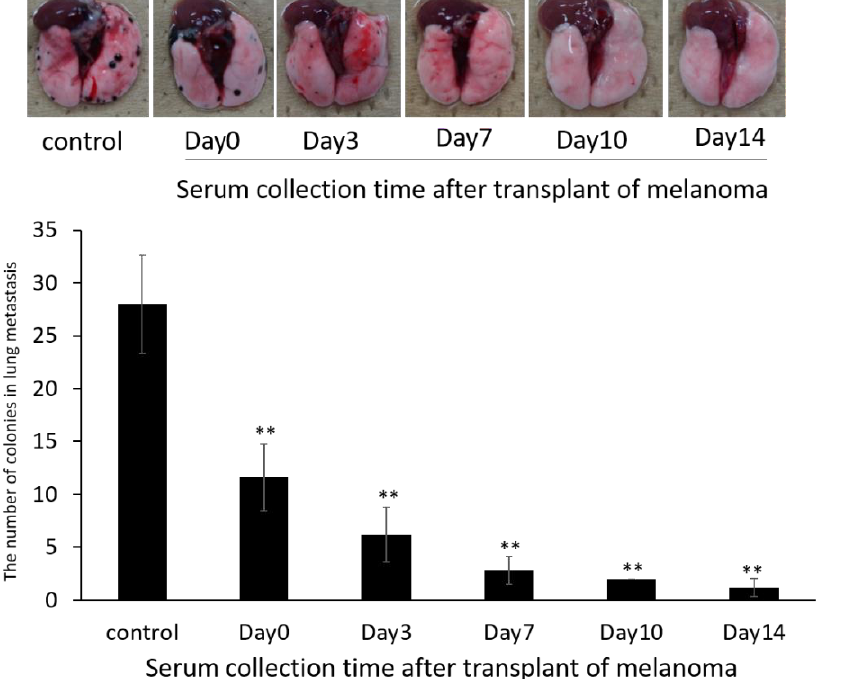
Figure 5. Anti-metastatic effects of siRNA-loaded exosomes prepared using exosomes derived from autologous serum collected at different timepoints from B16/BL6 spontaneous lung metastasis model mice. The number of colonies (lung metastases) were manually counted from images. Data represent the mean ± SD of five mice; ** p < 0.01 versus control B16/BL6 spontaneous lung metastasis model mice (Bonferroni test/ANOVA).